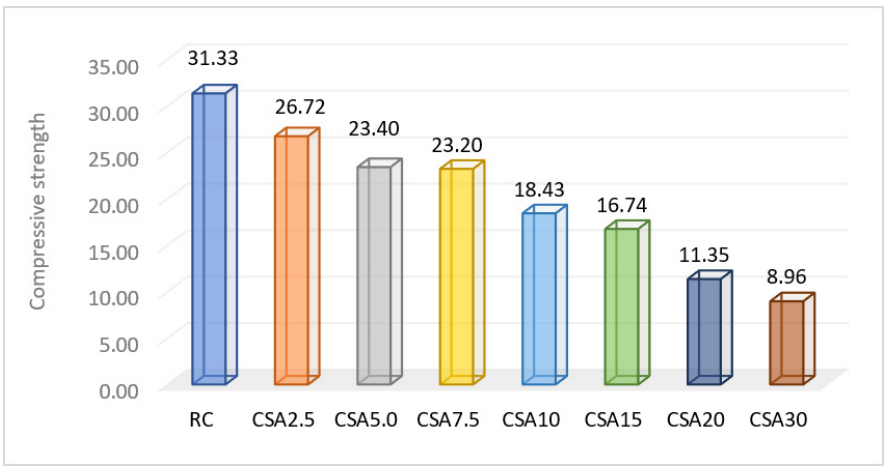
Figure 9. Compressive strength of the cement-based composites at 28 days (N/mm 2 ).